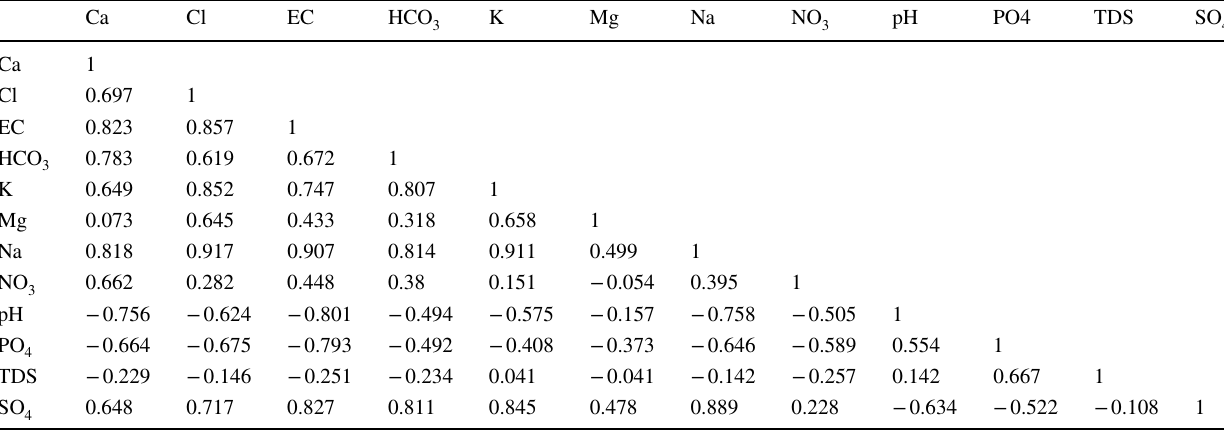
Table 4 Correlation matrix for groundwater samples in station of